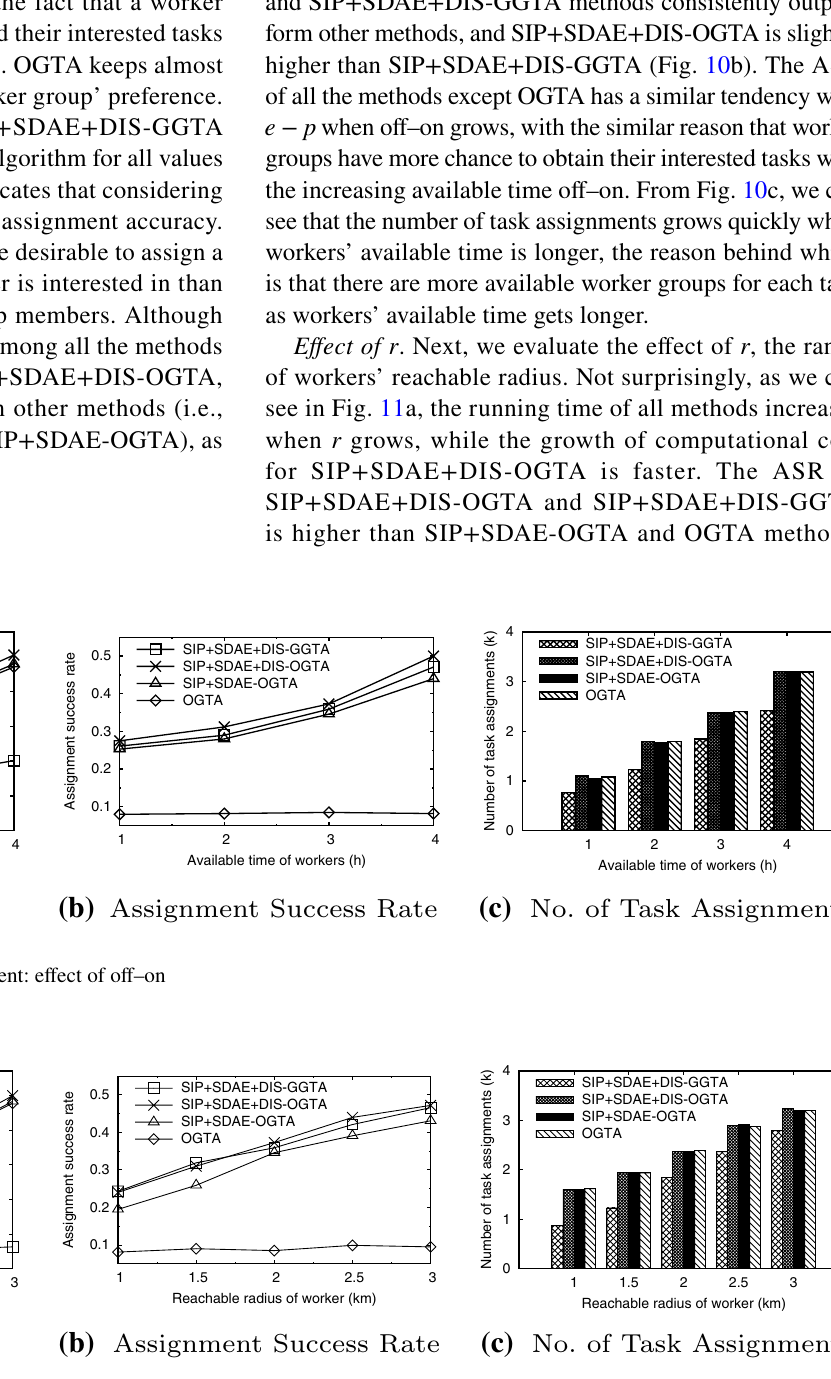
Fig. 11 Performance of group task assignment: effect of